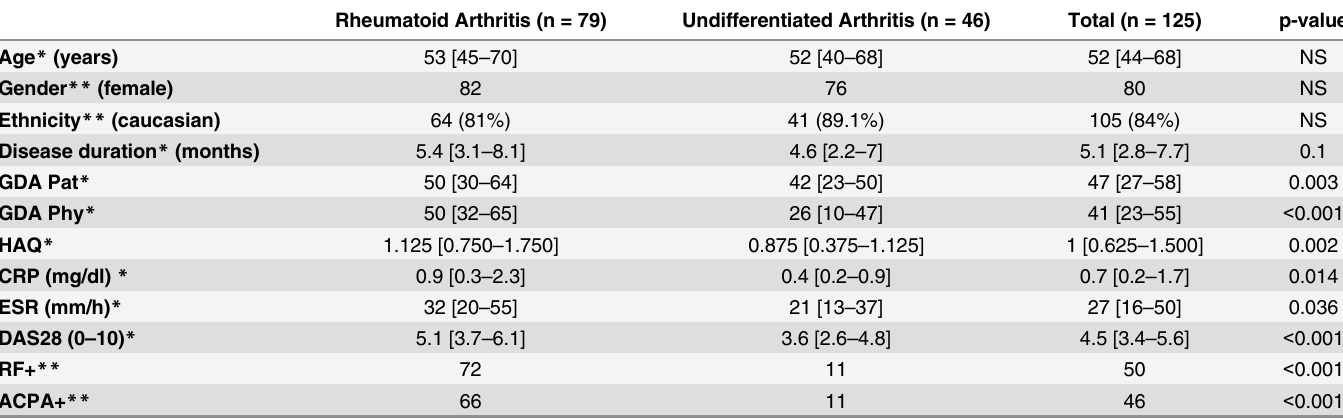
Table 1. Baseline characteristics of patients with early